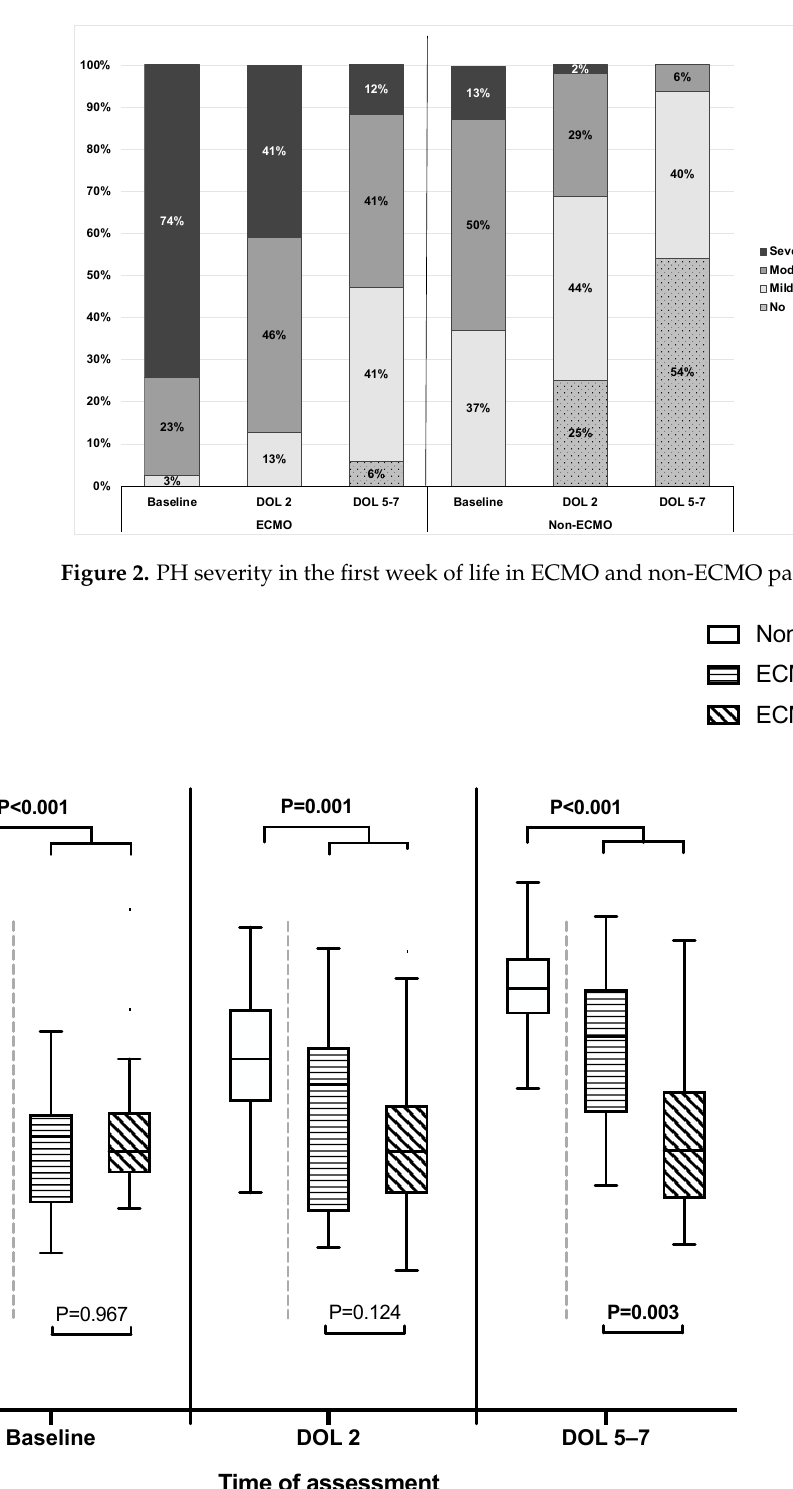
Figure 3. PAAT:ET values at baseline, DOL 2, and DOL 5–7 according to group allocation. Non-survivors had a significantly lower median PAAT:ET compared to survivors at baseline, DOL 2 and DOL 5–7. Additionally, the median PAAT:ET at baseline was significantly lower in patients subsequently receiving ECMO support compared to non- ECMO-patients ( p < 0.001). Comparing survivors and non-survivors among the 39 ECMO patients, the median PAAT:ET values were similar at baseline and DOL 2, but